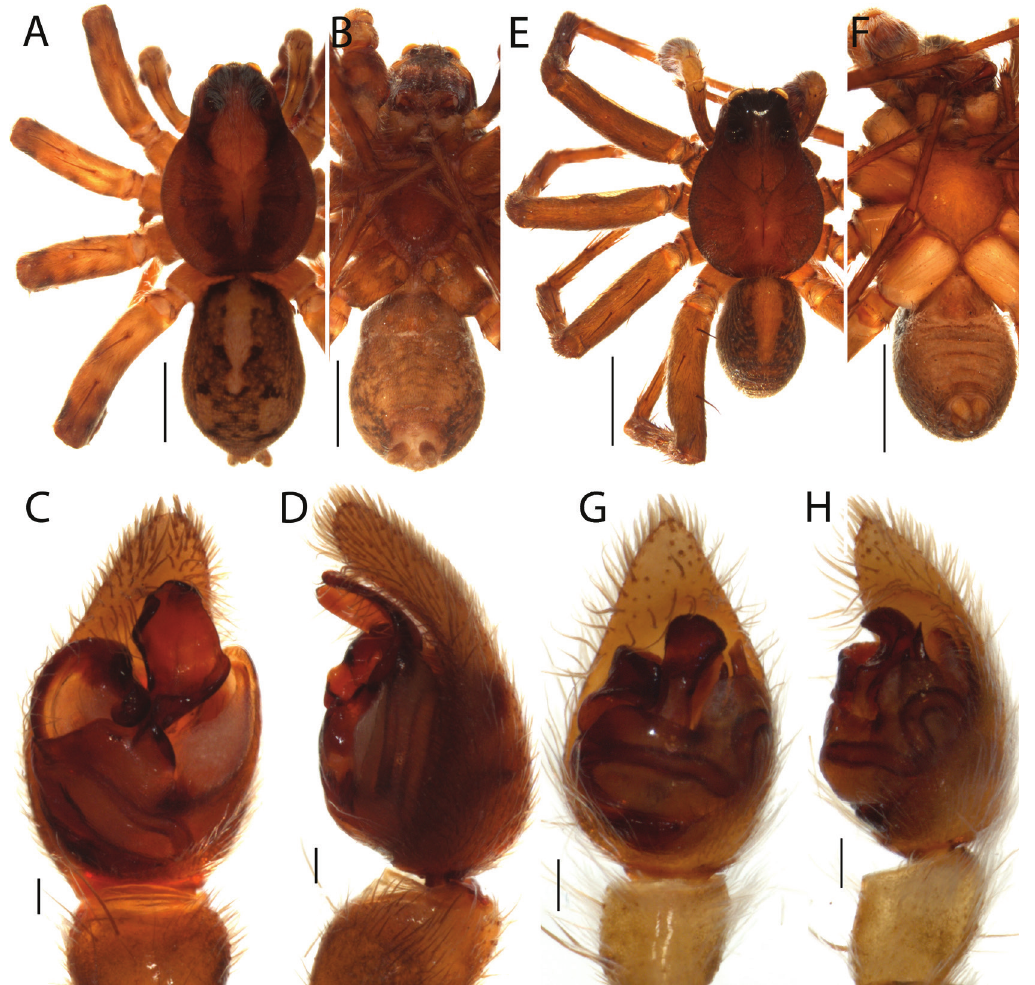
Figure 36. A–D , Artoria slatyeri sp. n., male holotype (AM KS127752), E–H , A. strepera sp. n., male holotype (AM KS127760): A , habitus, dorsal view; B , habitus, ventral view; C , male pedipalp, ventral view; D , male pedipalp, retrolateral view; E , habitus, dorsal view; F , habitus, ventral view; G , male pedipalp, ventral view; H , male pedipalp, retrolateral view. Scale bars: habitus 1.0 mm; pedipalp 0.1